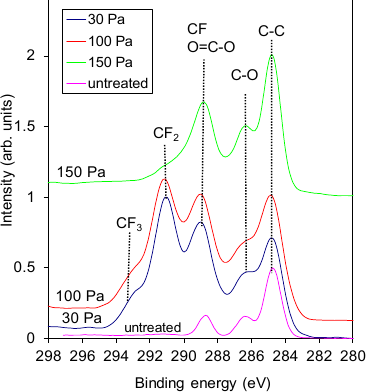
Figure 3. Comparison of high-resolution spectra C 1s of samples treated at various SF 6 pressures. A spectrum for the untreated PET is added for comparison.